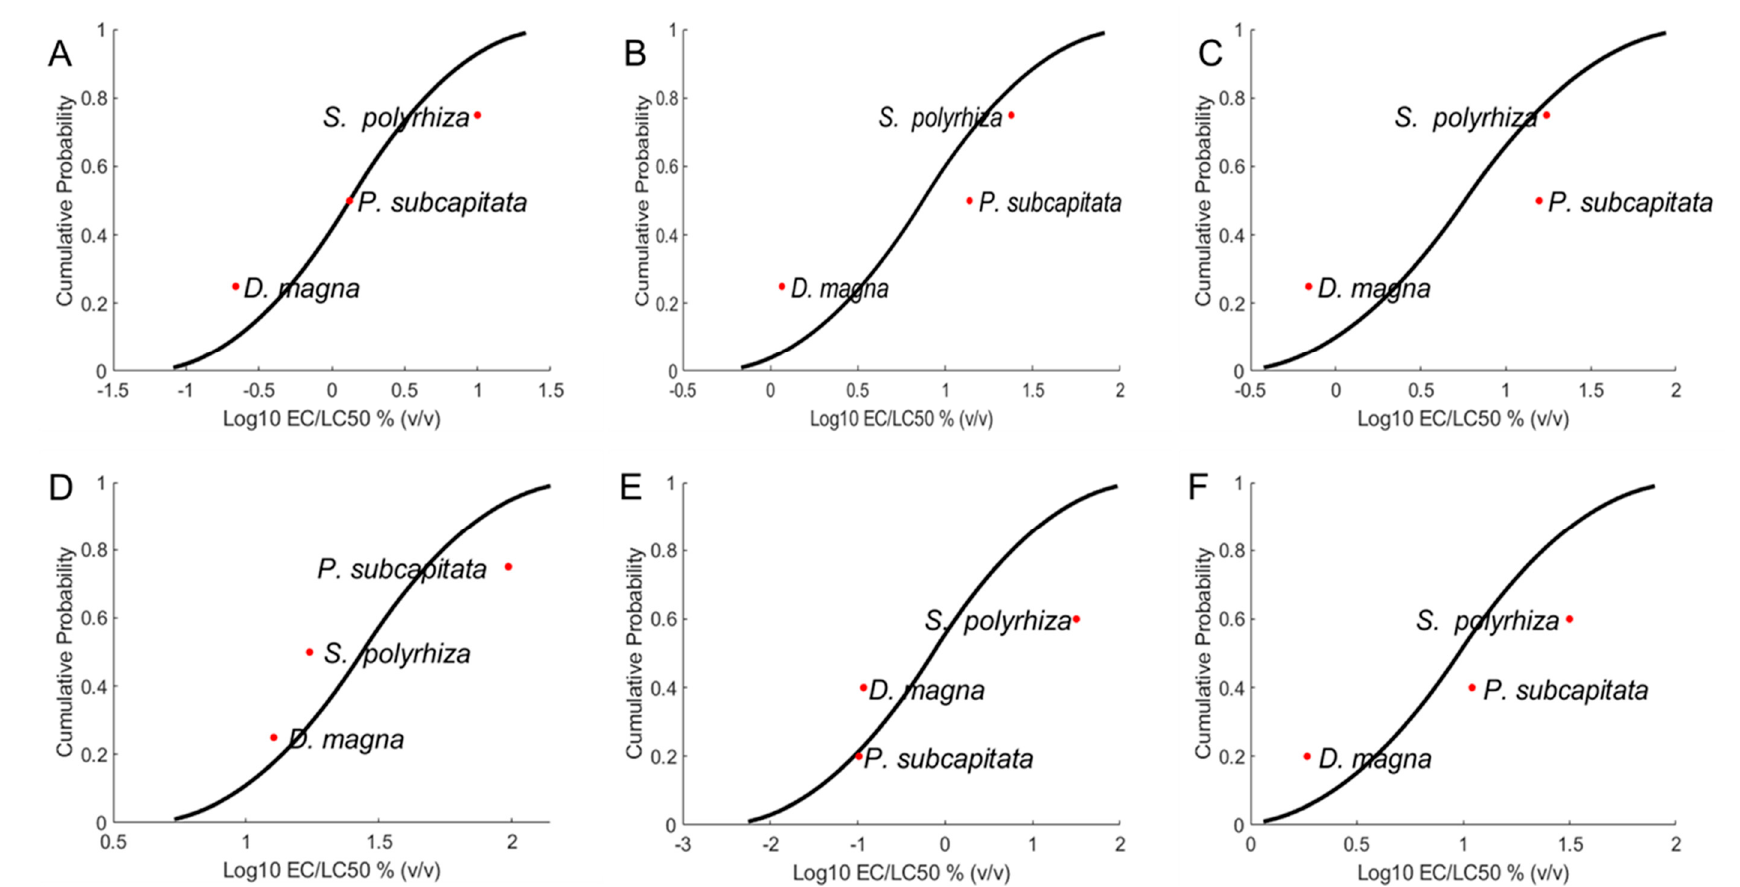
Figure 4. Species sensitivity distributions plot illustrating different responses of the three aquatic organisms to SUN1 ( A ), SUN2 ( B ), SUN3 ( C ), CA1 ( D ), SAN1 ( E ), and SK1 ( F ) PR-ENMs; D. magna and S. polyrhiza were the organisms with the highest and lowest sensitivity, except for CA1 ( D ) and SAN1 ( E ) PR-ENMs.